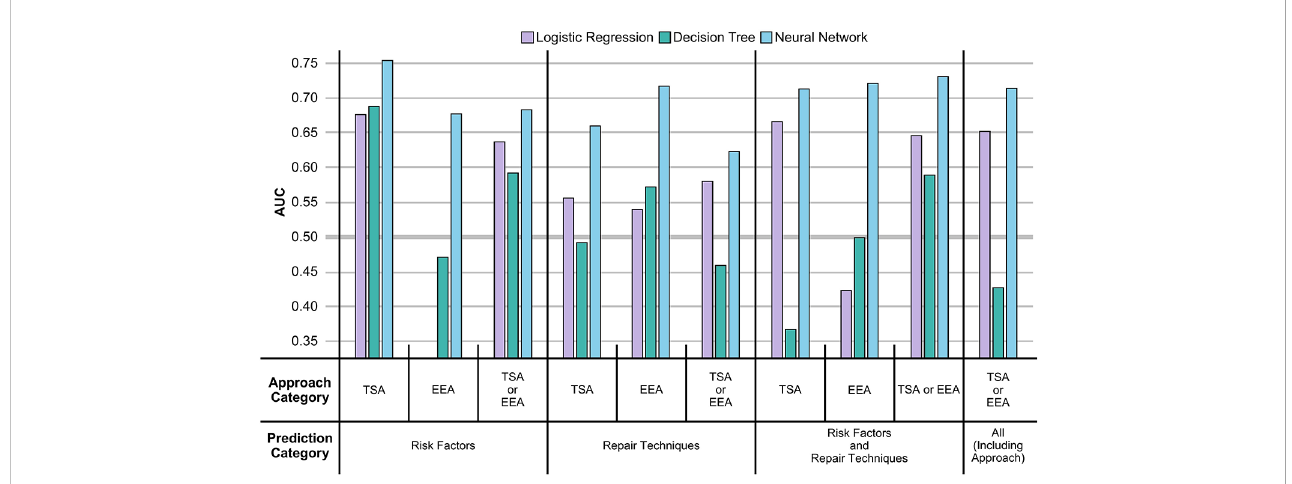
FIGURE 2 AUC of MLs displayed as a vertical bar chart. The AUC scale ranges from 0.35 to 0.75, with a thicker line at 0.50. Error bars representing the standard deviation across the 5-folds are not given. The AUC for LRs in the risk factors EEA case is not displayed as the AUC (0.22) is too low. The full values, including the standard deviation error bars, can be seen in Table